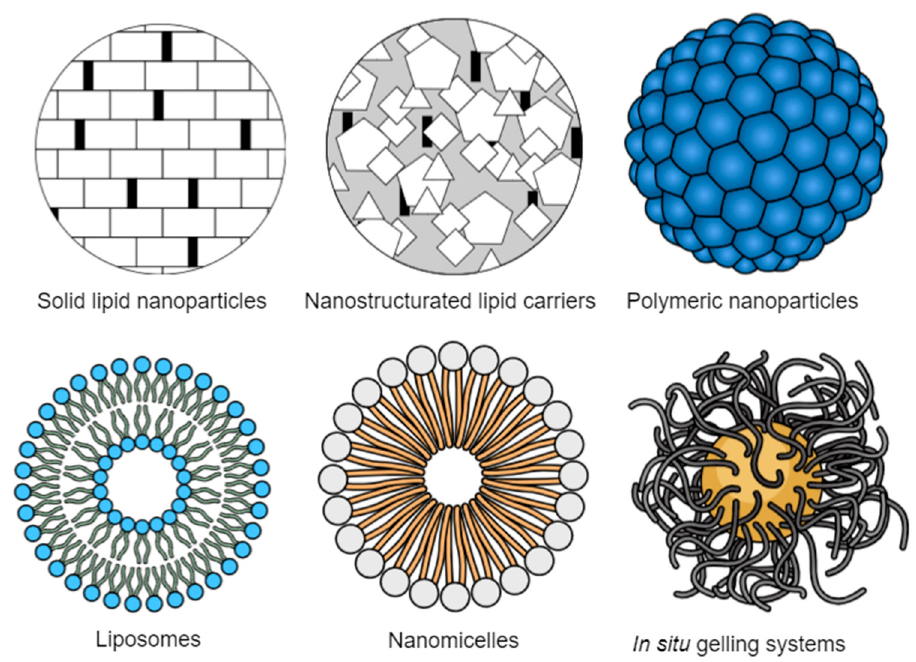
Figure 2. Most recent drug delivery systems used to overcome ocular barriers. (Source: authors’ own drawing).